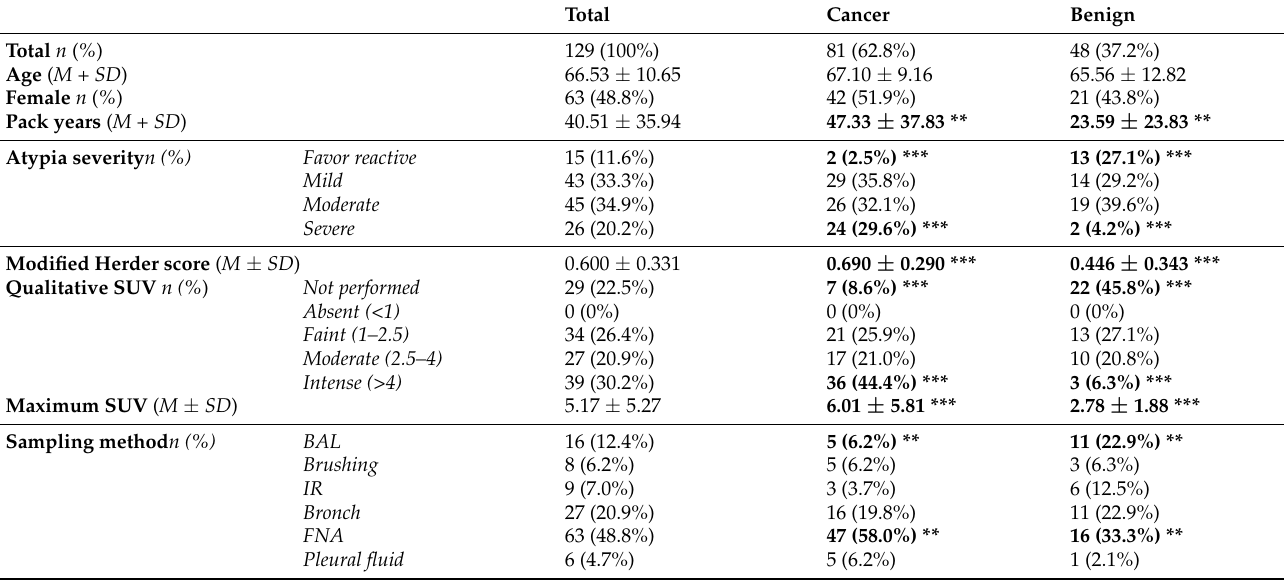
Table 1. Sample characteristics and results of Chi-square, Fisher’s exact, and Mann–Whitney U